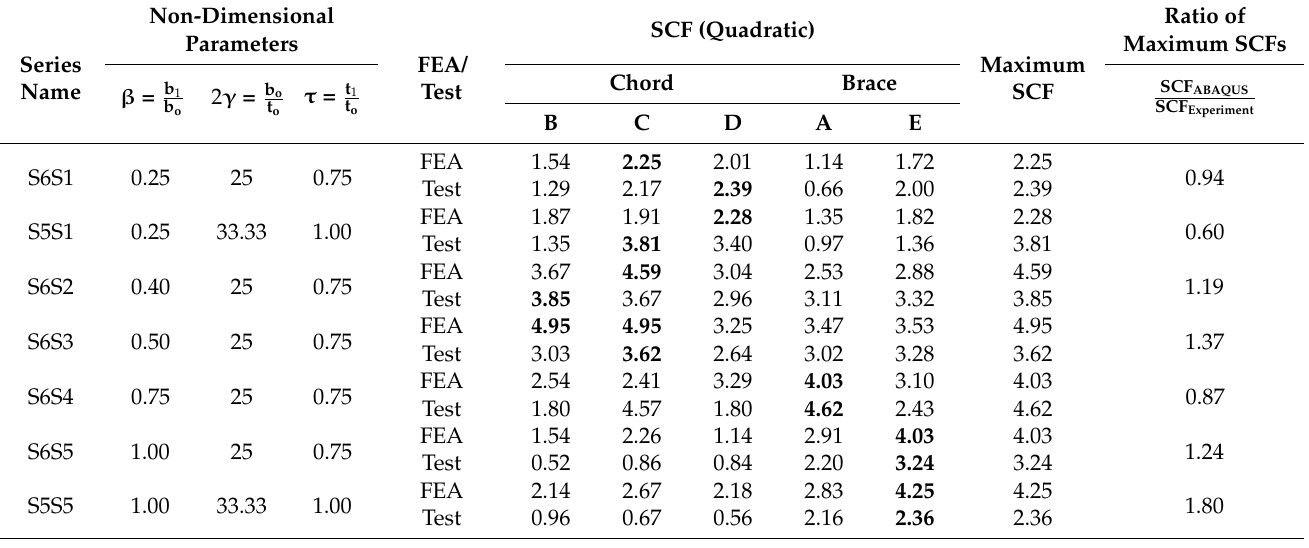
Table 9. Experimental and numerical SCFs of concrete-filled T-joints under in-plane